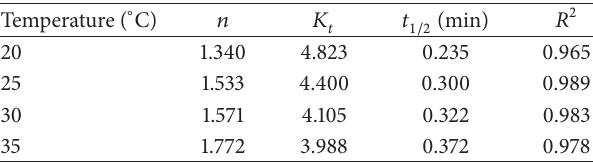
Table 1: Avrami exponent ( 𝑛 ), Avrami constant ( 𝐾 𝑡 ), and half-time of crystallization ( 𝑡 1/2 ) for MAG organogels at 20, 25, 30, and 35 ∘ C,